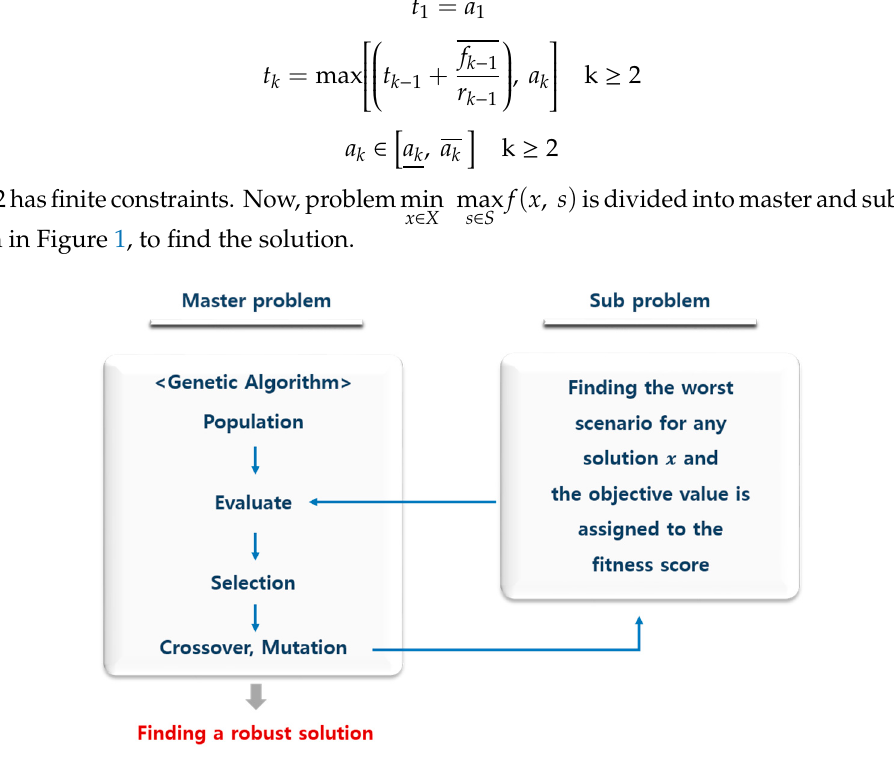
Figure 1. Robust optimization (RO) approach using scenario concept.